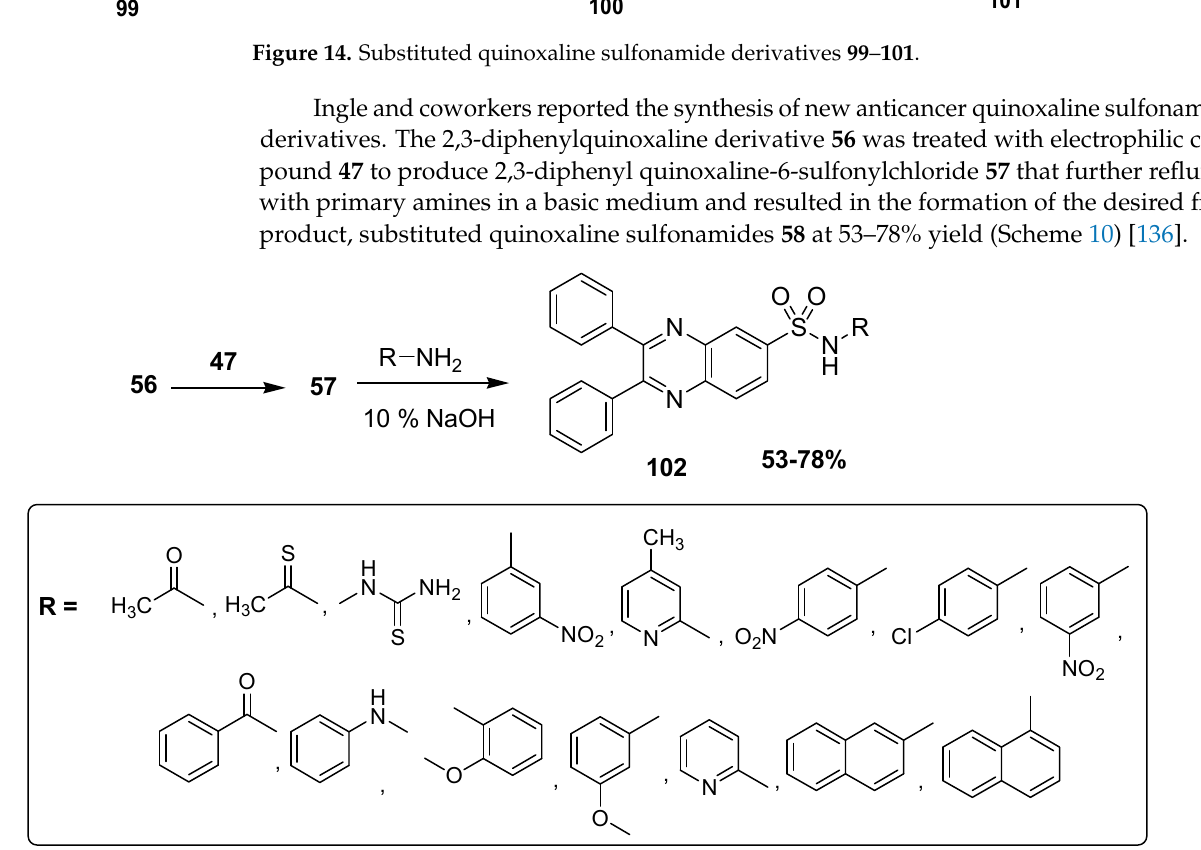
Scheme 9. Synthesis of quinoxaline moiety-based benzene sulfonamides with structure 98 . The quinoxaline sulfonamide derivative 99 displayed the most potent antitumor ac- Table 9. Anti-tumor activity of quinoxaline sulfonamides 99 – 101 . tivity against the liver carcinoma cell line (IC 50 value 0.5 µg m/L), while moderate an- ti-tumor activity was exerted by 100 (IC 50 value 4.75 µg m/L, Table 9). The quinoxaline sulfonamide structural motif 101 demonstrated the least antitumor activity, exhibiting an IC 50 value of 6.79 µg m/L. The SAR described that the presence of a carboxylic acid group on the quinoxaline was responsible for the potent antitumor activity of 99 , while its ab- sence in 100 led to a moderate activity. The absence of the isoxazole in 101 produced the worst action herein (Figure 14) [135]. Table 9. Anti-tumor activity of quinoxaline sulfonamides 99–101 .